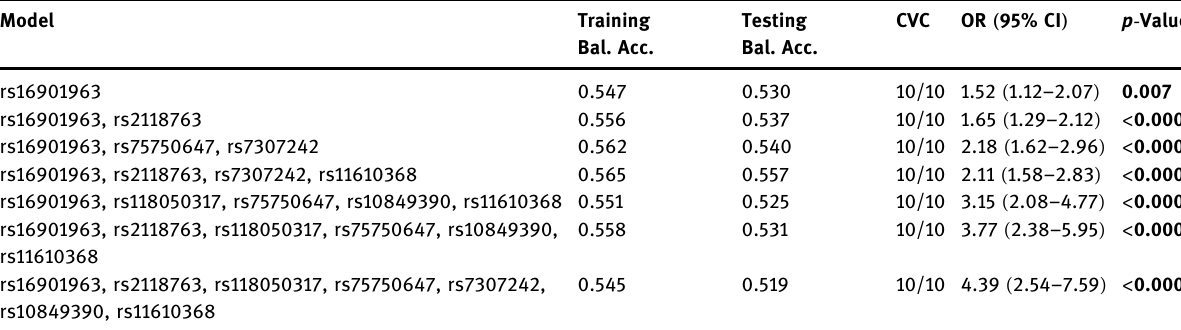
Table 7: MDR analysis of SNP – SNP interactions of MRPS30 - DT and NINJ2 variants Model Training